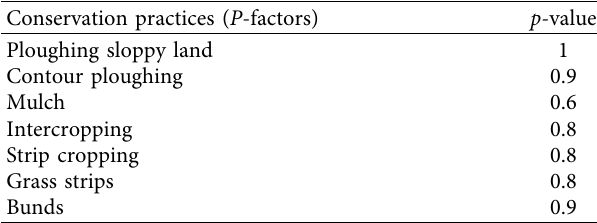
Table 3: Management Practice was developed by [40].